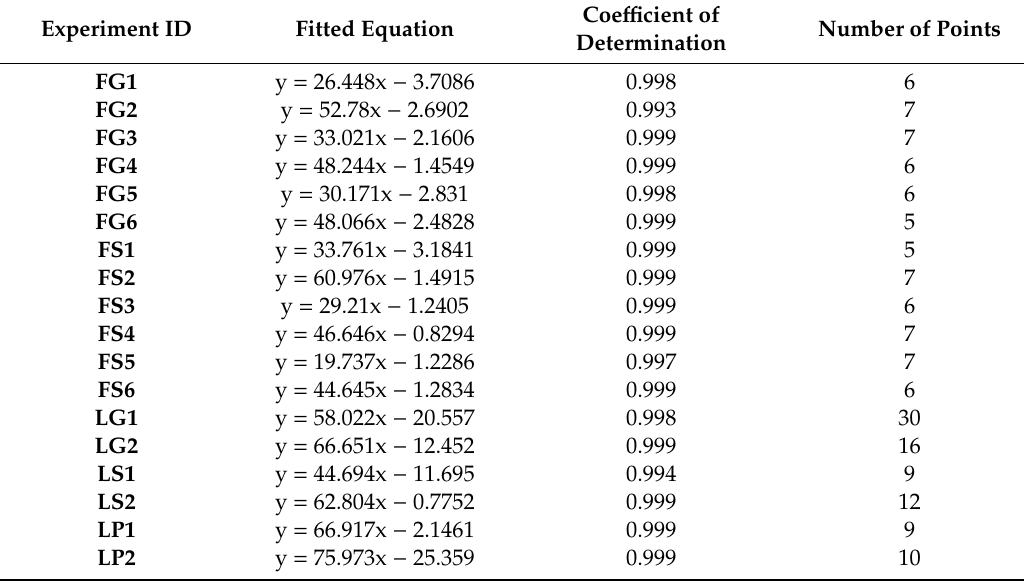
Table A2. Calculation of the final constant runo ff (mm h − 1 ) using linear regression on the measured runo ff/ time dataset. Constant runo ff is calculated as the steepness of the function (parameter a in y = a x − b). The number of points gives the quantity of measured data used to fit